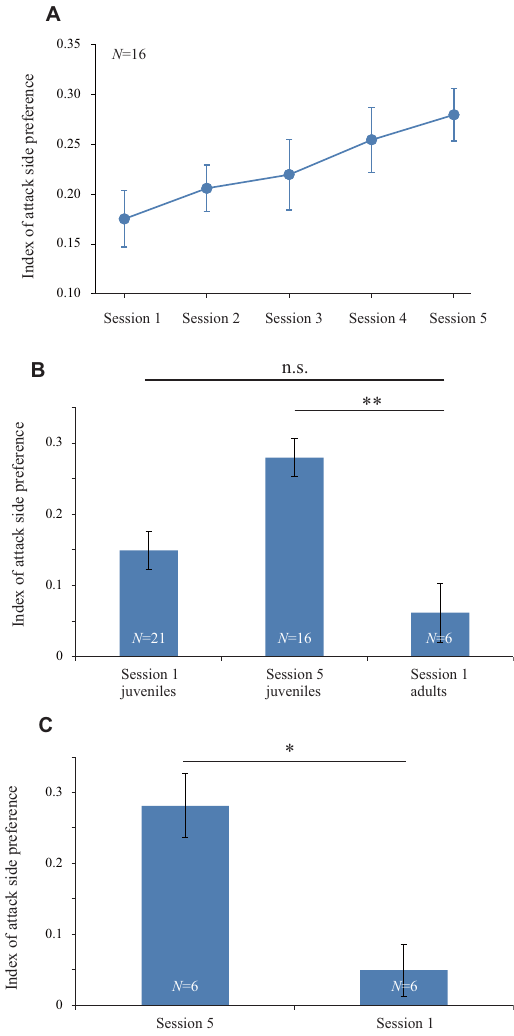
Figure 2. Comparison of attack side preference during repeated experiments. ( A ) The temporal change in attack side preference from Sessions 1 to 5 (mean ± standard error [SE], N = 16 fish). ( B ) The attack side preference during Sessions 1 and 5 for juveniles and Session 1 for adults. P-values are from the Wilcoxon rank-sum test. ( C ) Differences in the level of attack side preference between Sessions 5 and 1 conducted on the same day of age. P-values are from the Wilcoxon signed-rank test. * P < 0.05. ** P < 0.01. n.s., not significant ( P >